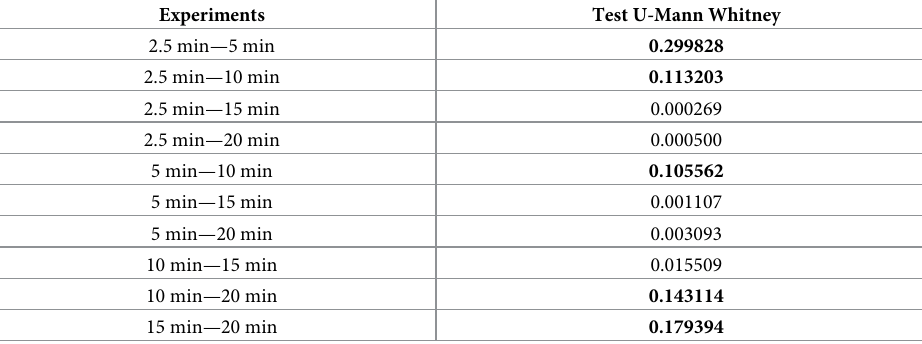
Table 4. Statistical differences between the groups of